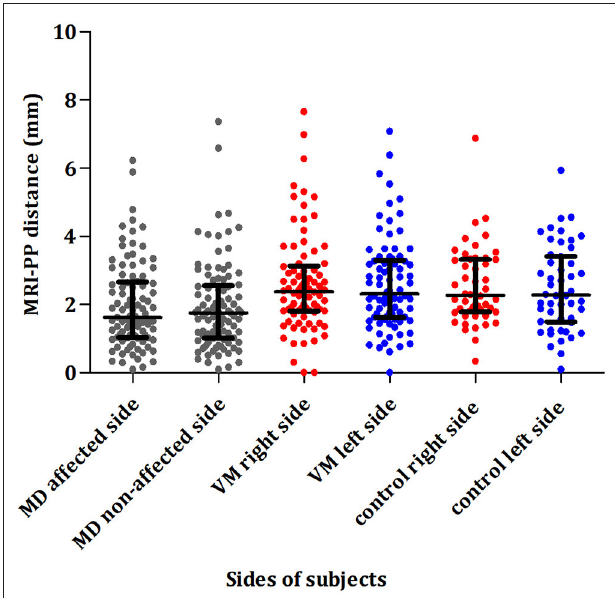
FIGURE 4 | Comparison of the distance between the vertical part of the posterior semicircular canal and the posterior fossa (MRI-PP) distance in patients with unilateral MD (affected and non-affected side), patients with VM (right and left side), and control subjects (right and left side). MD, Ménière’s disease; VM, vestibular